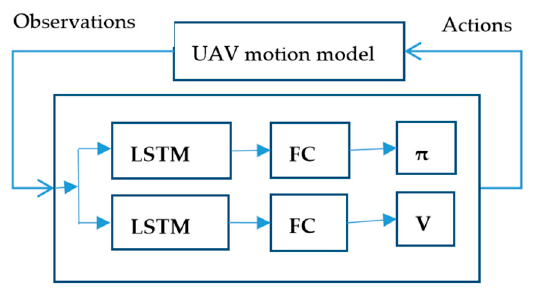
Figure 2. The single ‐ agent PPO algorithm and the unmanned aerial vehicle (UAV) motion model for the feedback loop.